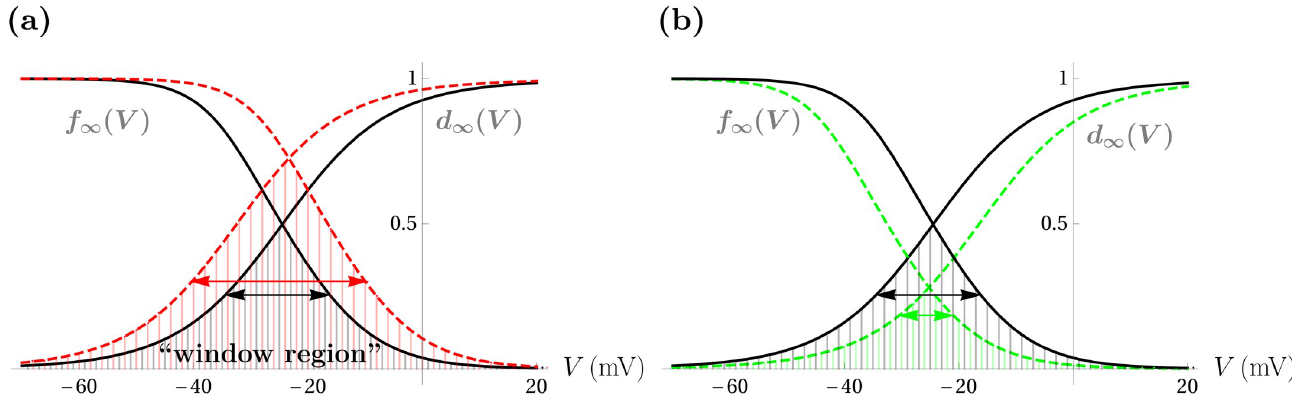
Fig 2. Schematic of symmetric broadening and narrowing of the I Ca-L window region. ( a ) A left shift in d 1 ( V ) and a right shift in f 1 ( V ) (red curves) increases the area (filled with vertical red lines) under both curves as compared to the default setting (black curves with area colored with vertical gray lines). ( b ) A right shift in d 1 ( V ) and a left shift in f 1 ( V ) (green dashed curves) narrows the window region. The default area is colored gray and the reduced area is colored green.